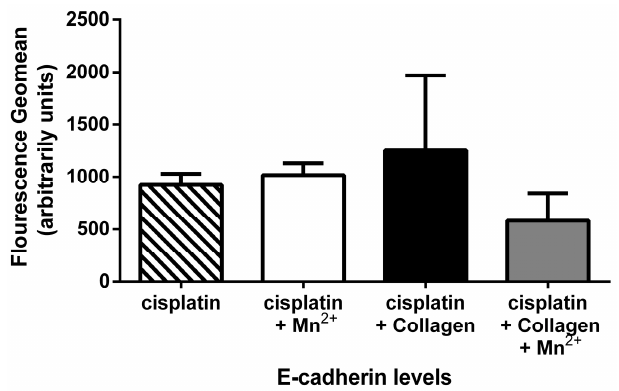
Figure 7. E-cadherin expression. E-cadherin protein levels were accessed by FACS after 72 h of incubation with cisplatin (IC 50 ). MV3 cells were grown in cell culture flasks either coated with collagen type I or uncoated and, depending on the treatment, incubated with manganese enriched cell culture medium, for 5 min, prior to the addition of cisplatin. Results show no detectable deregulation in E-cadherin levels, considering the geomean of at least n = 2 (SEM).